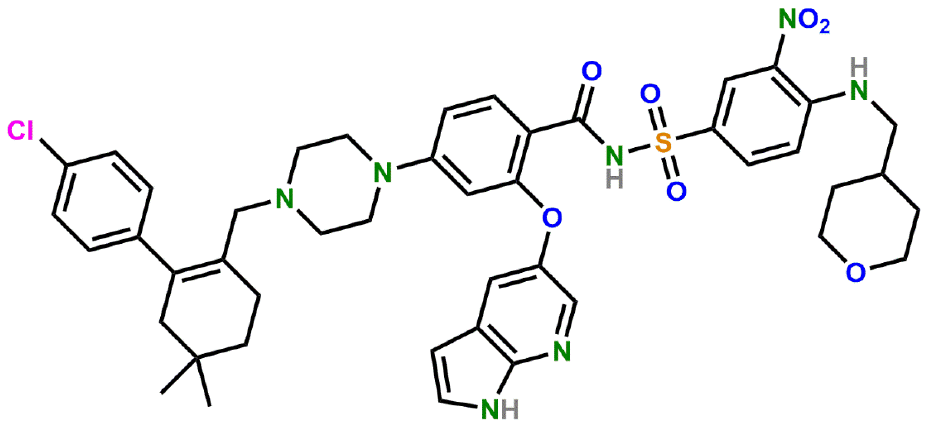
Figure 1. Structure of venetoclax.